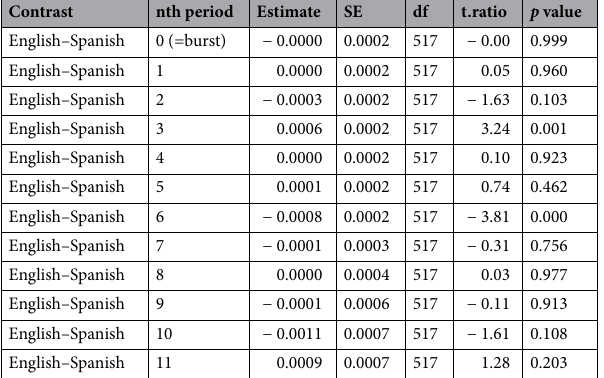
Table 3. Pairwise contrasts in peak timing difference between English and Spanish (despite significant interactions pooled across replications) in the Discriminator network (with emmeans package 70 ). The burst is marked by the 0th period. The 12th period is not estimated due to lack of